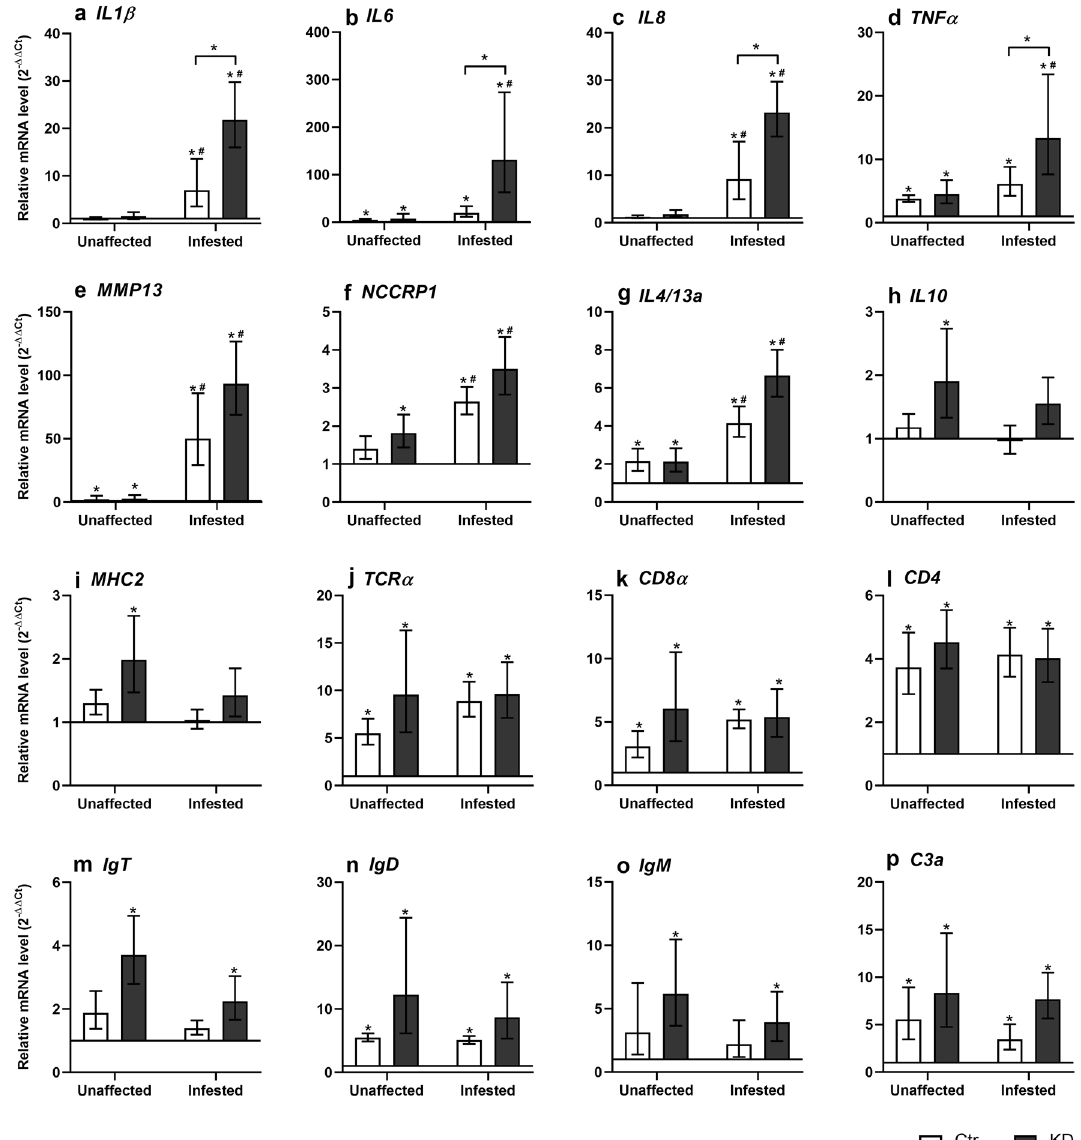
Figure 5. Relative transcript level (2 −∆∆Ct ± SD) of selected Atlantic salmon immune gene transcripts in response to control (Ctr) and LsLGP2 knock-down (KD) copepodids 3 days post infestation. The expression in unaffected and affected sites on infested fish (N = 8) were related to elongation factor 1 alpha ( elf1α ) and tripartite motif ( trim ) genes (∆Ct) and to non-infested control fish (∆∆Ct). *Indicates significant differences (p ≥ 0.05) when compared to skin from non-infested fish. # Indicates significant differences (p ≥ 0.05) between unaffected and affected skin of infested fish. Significant difference (p ≥ 0.05) between skin sites infested with ctr and KD lice are also denoted with an asterisk